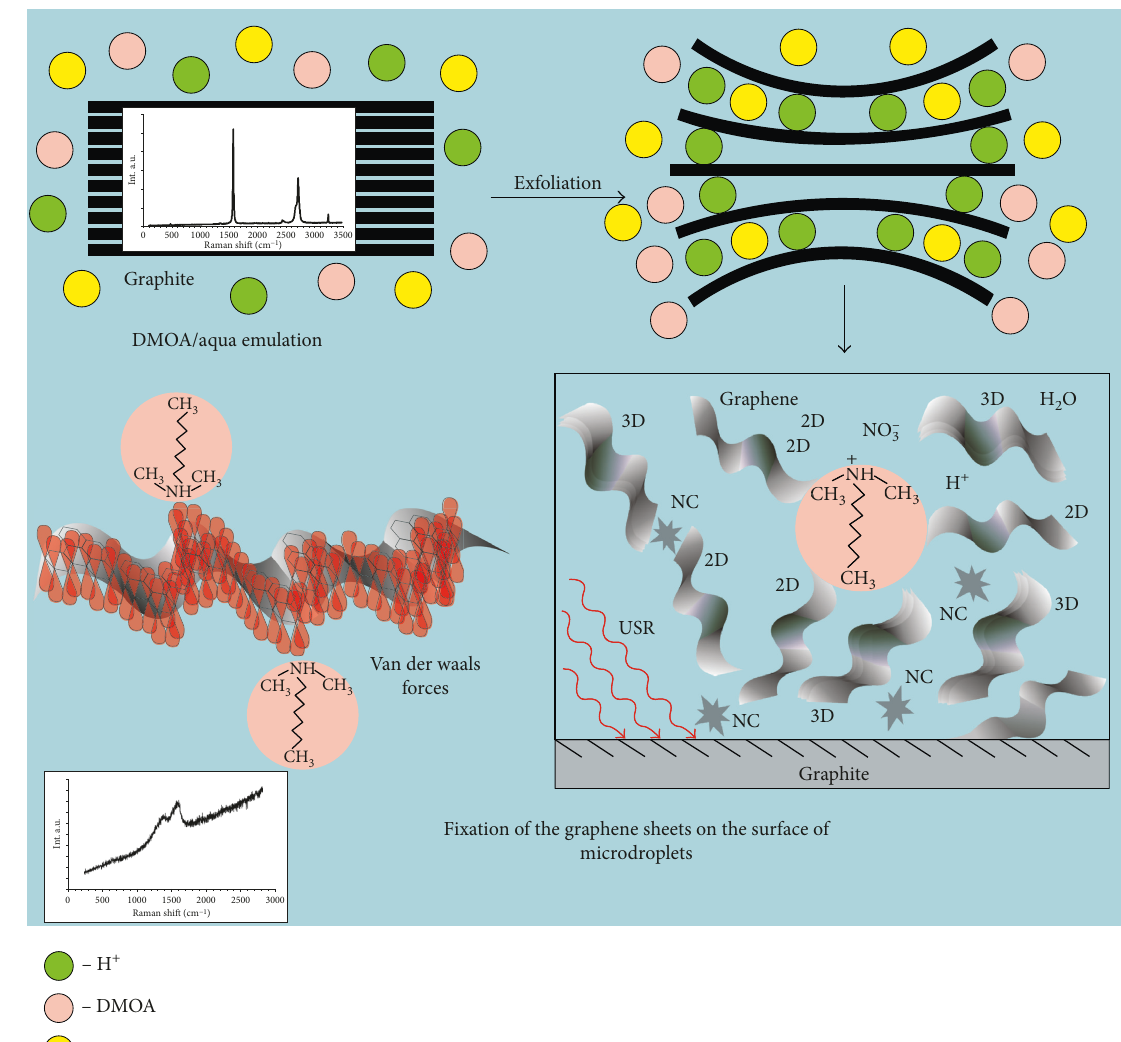
Figure 1: Mechanism for the formation of graphene by exfoliating graphite powder and its fixation on the surface of DMOA nanodroplets in acidified aqua-oil emulsion. NC: nanocarbon; USR: ultrasonic